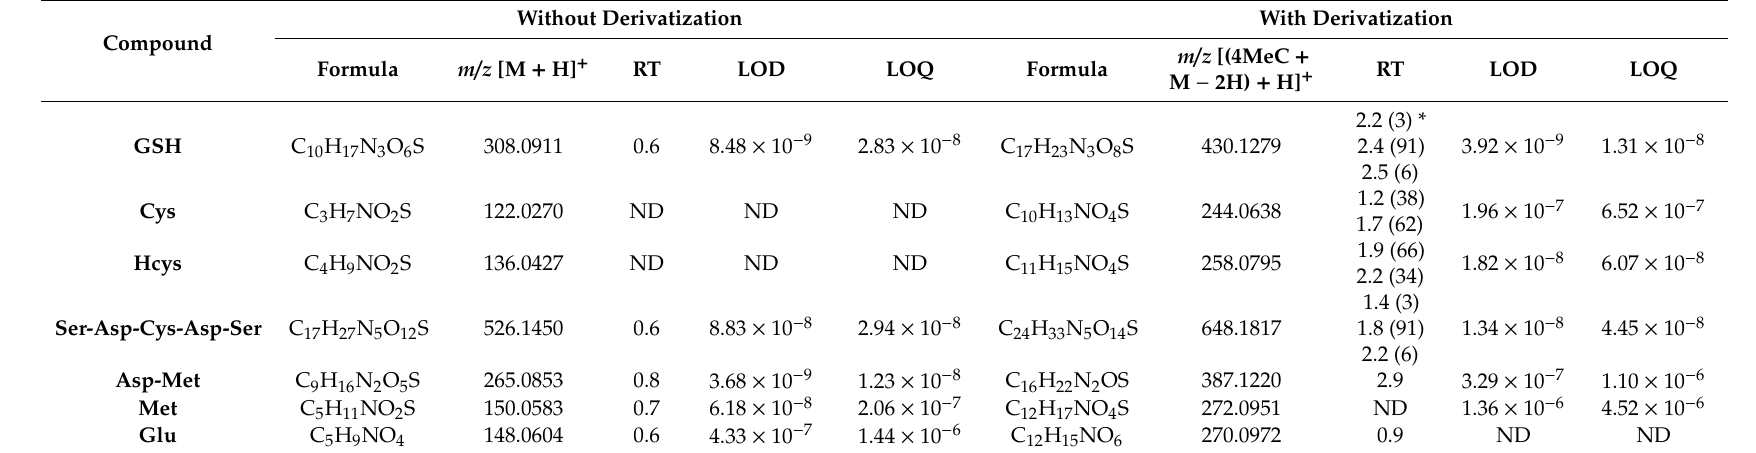
Table 1. Ultra-high-performance liquid chromatography coupled to a quadrupole-time of flight mass spectrometer (UHPLC-QqTOF-MS) analytical results (experimental m / z , retention time, limit of detection, limit of quantification) and prospective formulas of tested nucleophiles (GSH, Cys, HCys, Ser-Asp-Cys-Asp-Ser, Asp-Meth and Glu) with and without 4MeQ